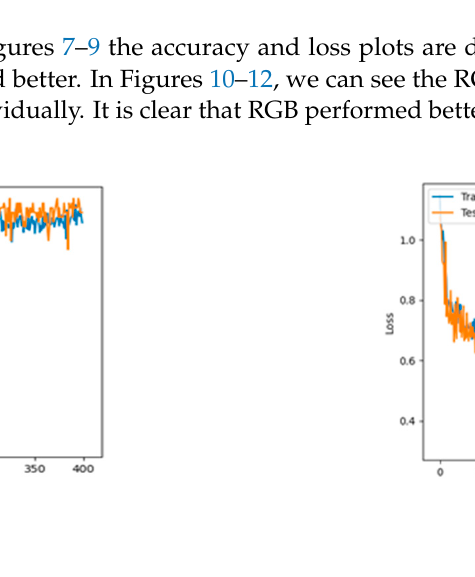
Figure 7. Plots demonstrating the best RGB-CNN for the CAD classification problem: ( a ) accuracy; ( b ) loss.